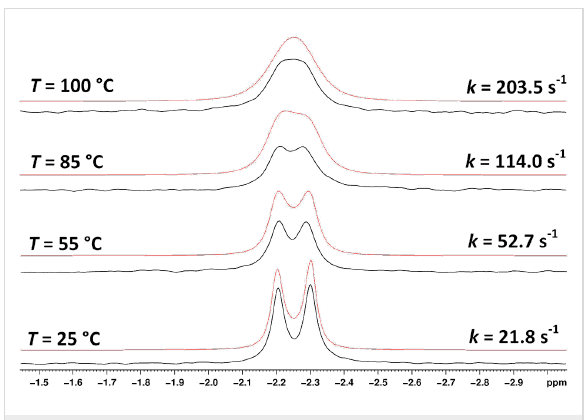
Figure 9: The 31 P NMR spectra (202.3 MHz) of 14 measured (the black curve) and simulated (the red curve) at various temperatures.